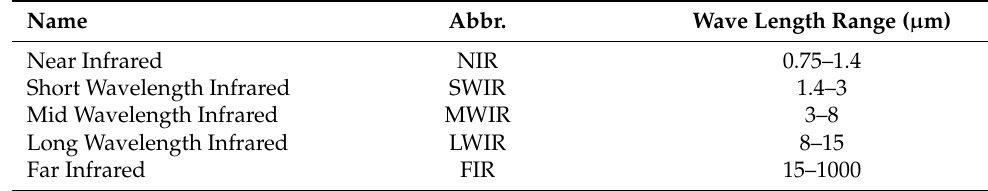
Table 4. The infrared spectrum bands, their abbreviations and corresponding